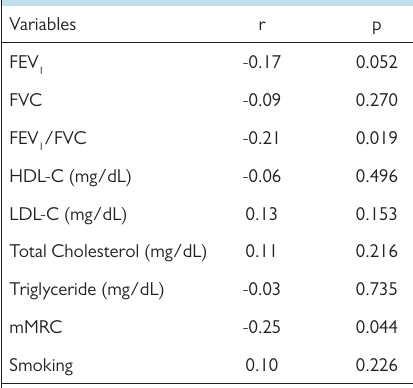
Total Cholesterol (mg/dL)